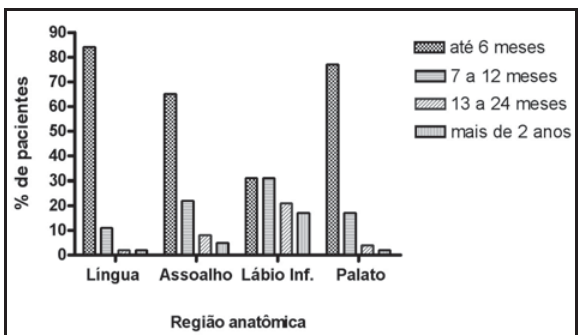
Figura 2 – História pregressa das lesões conforme a região anatômica